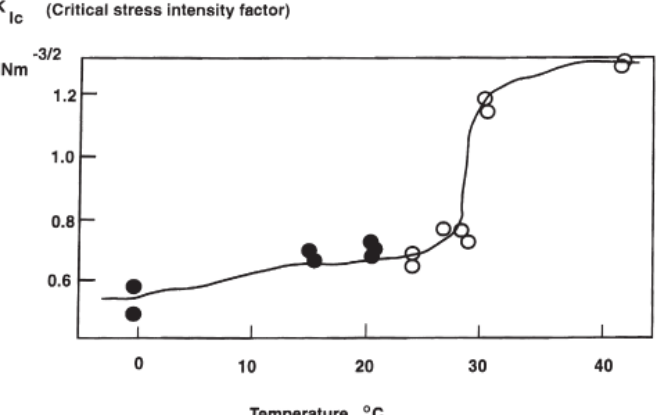
Figure 2. The temperature sensitivity of the dc volume resistivity and the dielectric loss tangent of the polyester resin [22]. , smooth fracture surface; , rough fracture surface. Strain rates are shown, 1 mm min -1 .